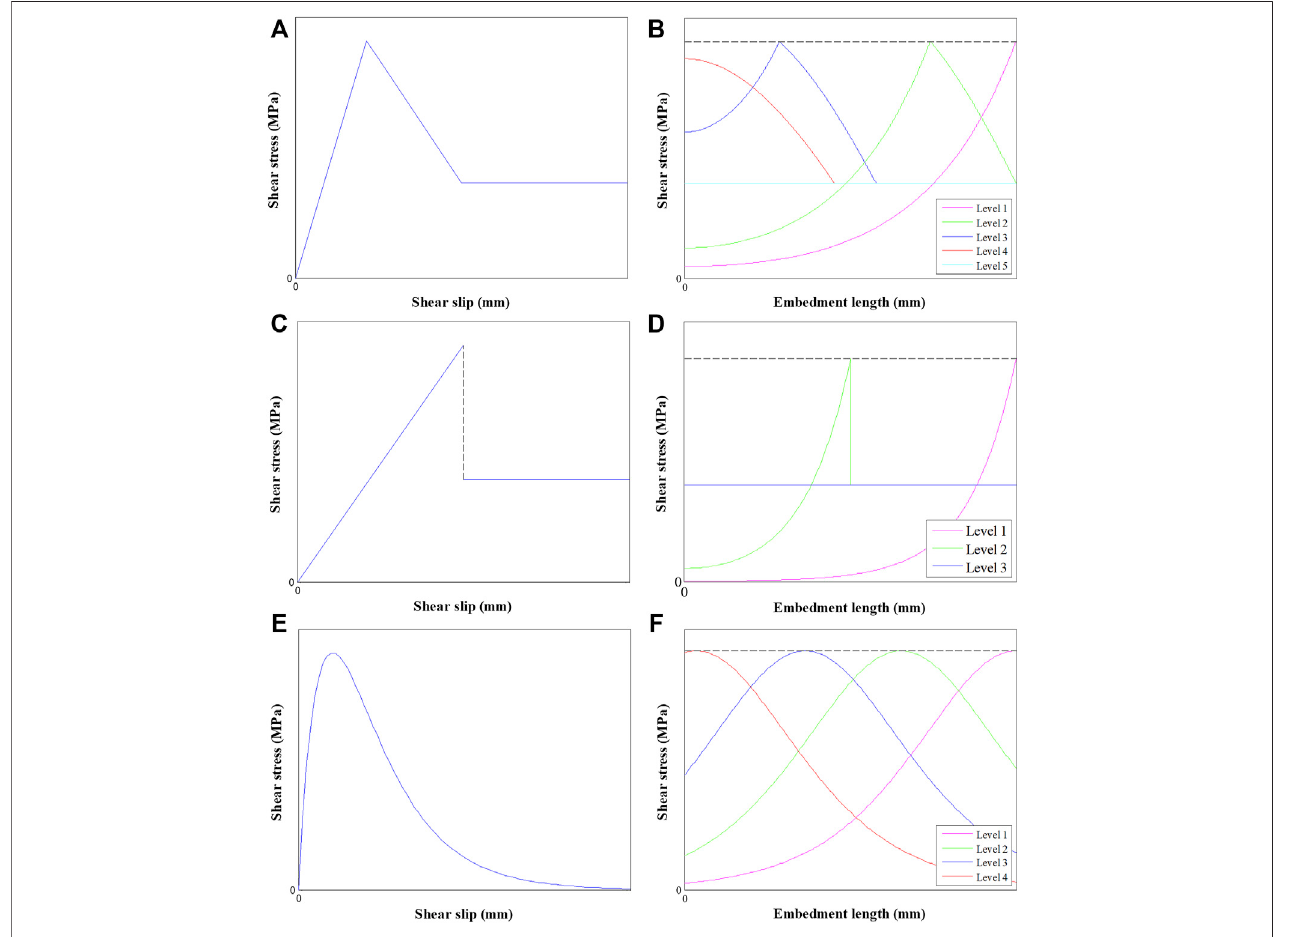
FIGURE 2 | SS propagation process: (A) Trilinear equation, (B) the corresponding SS propagation process, (C) bilinear equation, (D) the corresponding SS propagation process, (E) non-linear equation, and (F) the corresponding SS propagation process.